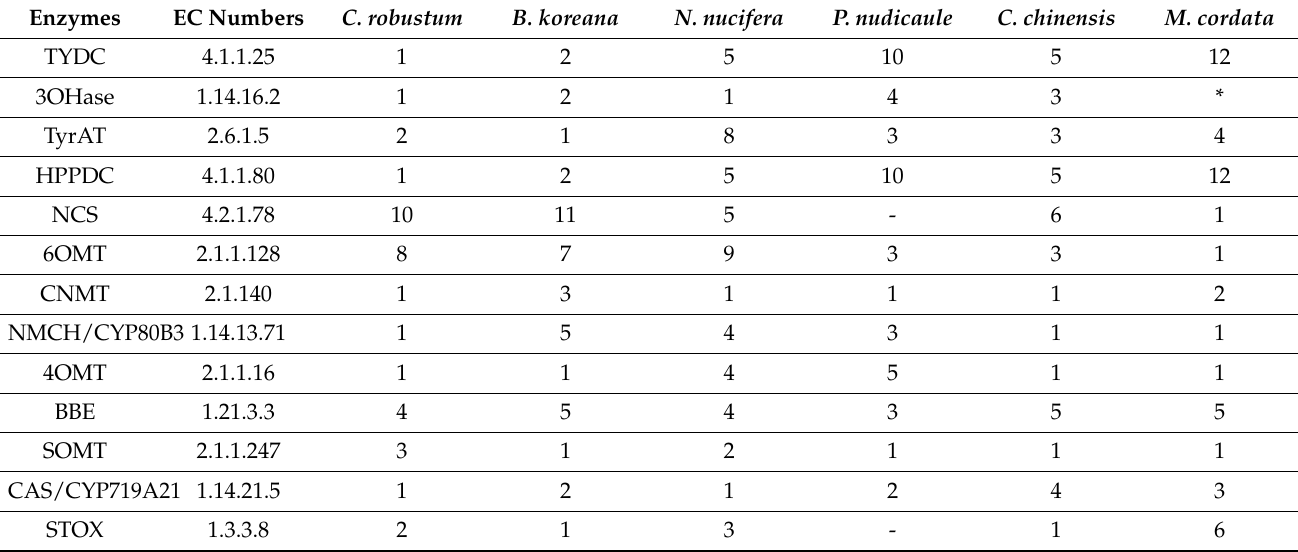
Table 3. Copies of the berberine synthesis genes in C. robustum , B. koreana , N. nucifera , P. nudicaule , C. chinensis , and M. cordata